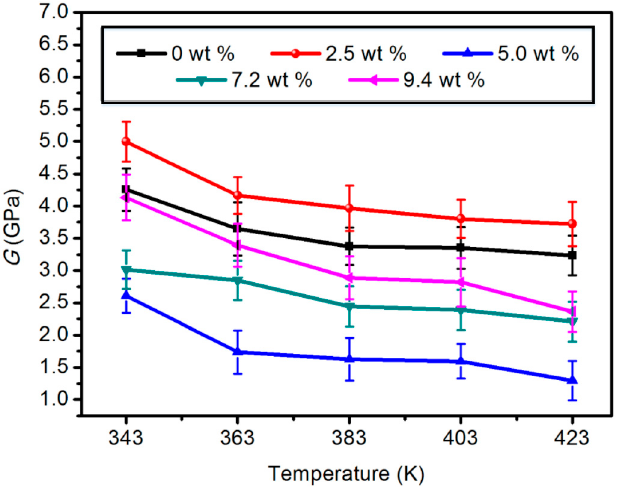
Figure 3. Shear modulus of five different content composite models.